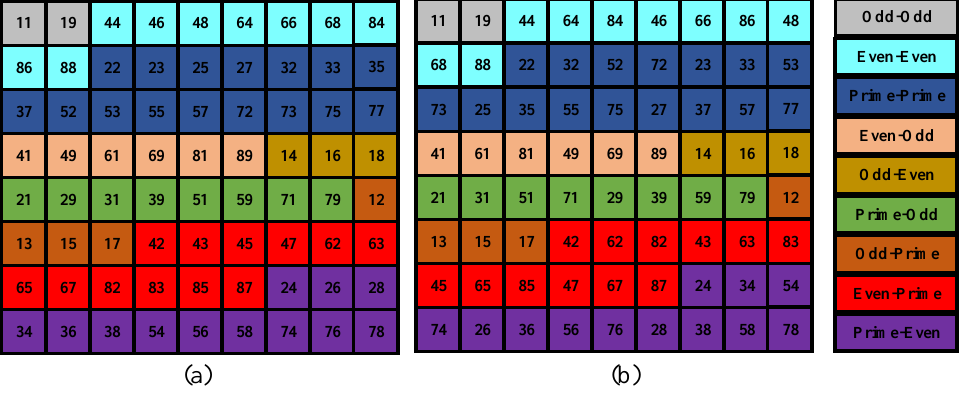
OEP and IOEP reconfigurations are mainly useful for the rectangular PV array. There- fore, the proposed IOEP reconfiguration tested on a 8 × 9 PV array. All the shadings have